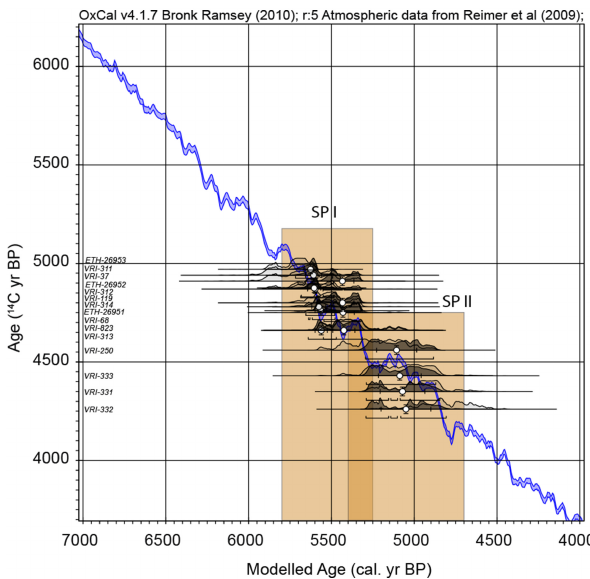
Fig. 3. Chronology of settlement periods at Lake Mondsee. Twelve published AMS radiocarbon dates from three Neolithic lake- dwelling sites (“’See”, “Scharfling” and “Mooswinkel”) were cali- brated and used as input parameters for period modelling with Ox- Cal 4.1 (Ramsey, 2009). Two different settlement periods can be distinguished: SP I from ca. 5800 to 5250 cal. yr BP and SP II from ca. 5400 to 4700 cal. yr